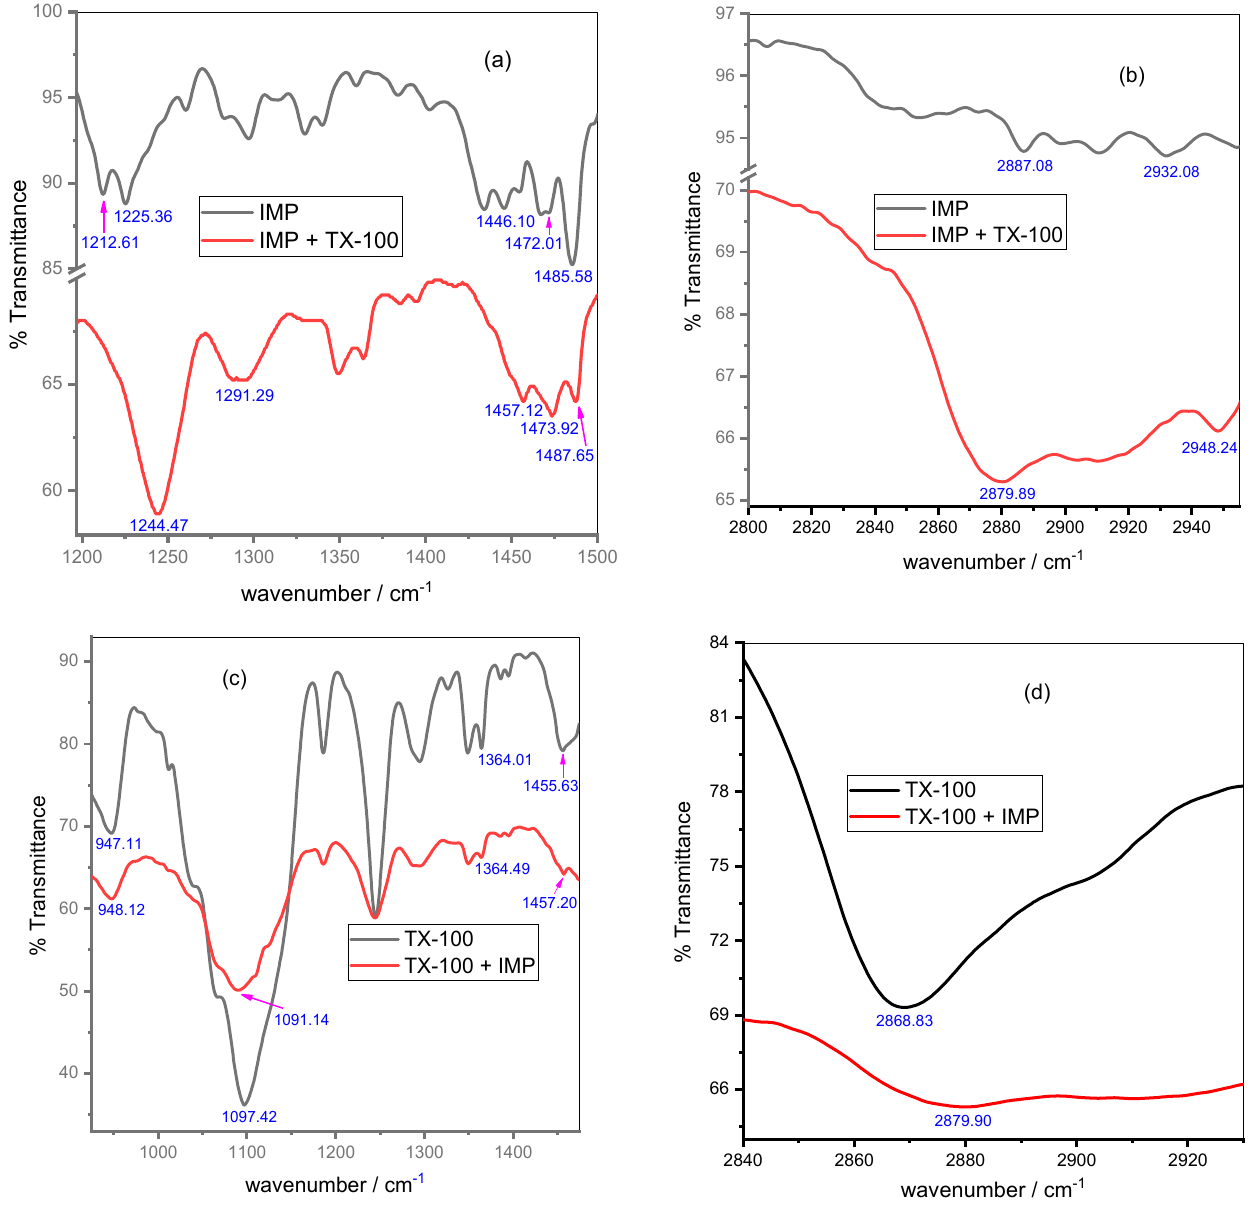
Figure 5. FTIR spectra of IMP ( a , b ) in the absence and existence of TX-100 and FTIR spectra of TX-100 ( c , d ) in the absence and existence of IMP in the selected wavenumber regions (cm − 1 ).